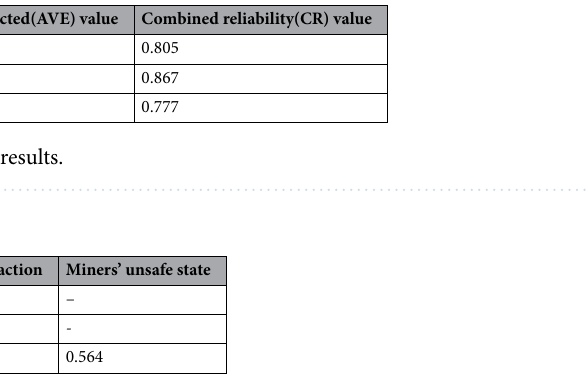
Table 4. Discriminant validity: Pearson correlation and AVE square root value.